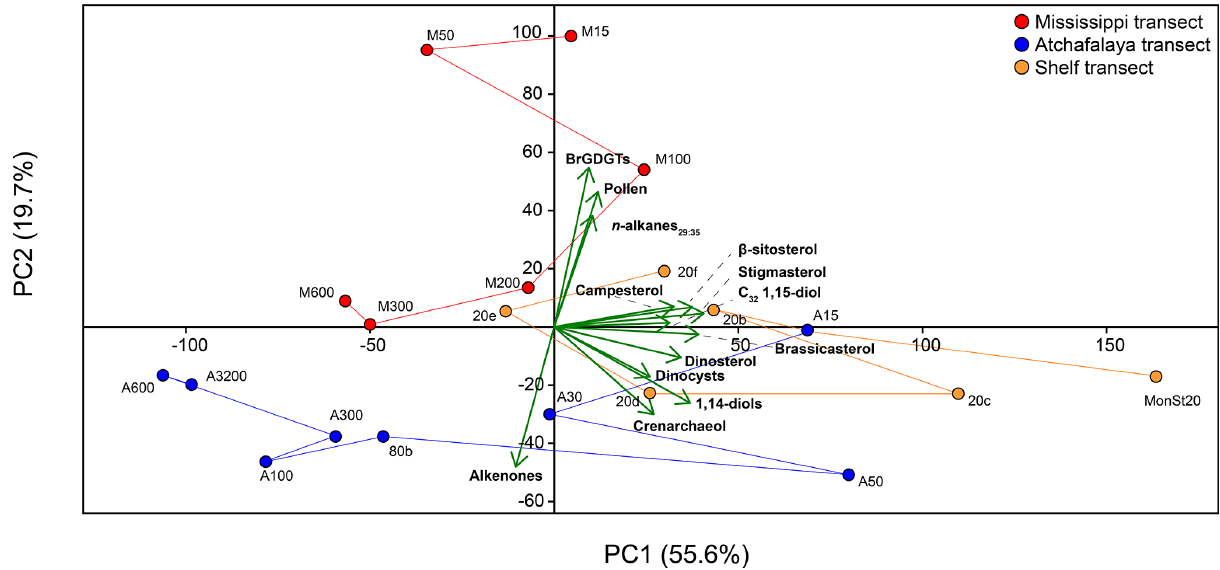
Figure 9. PCA on concentrations of brGDGTs, pollen, n -alkanes 29 : 35 , the C 32 1,15-diol, campesterol, β -sitosterol, stigmasterol, brassicas- terol, dinosterol, dinocysts, 1,14-diols, crenarchaeol, and alkenones in surface sediments of the GoM. Lines connecting sample locations represent the scores of the different